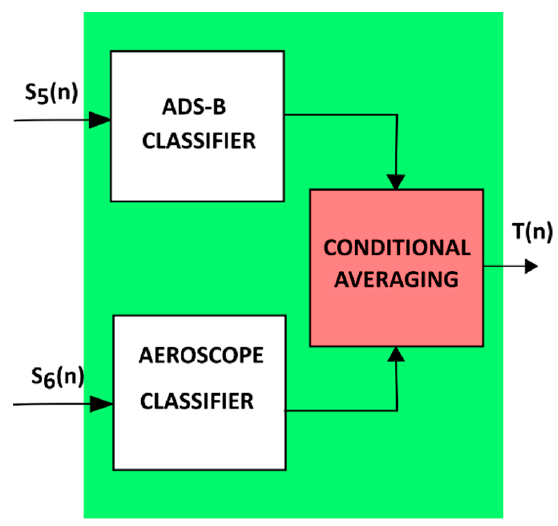
Figure 7. Transponders data fusion idea.